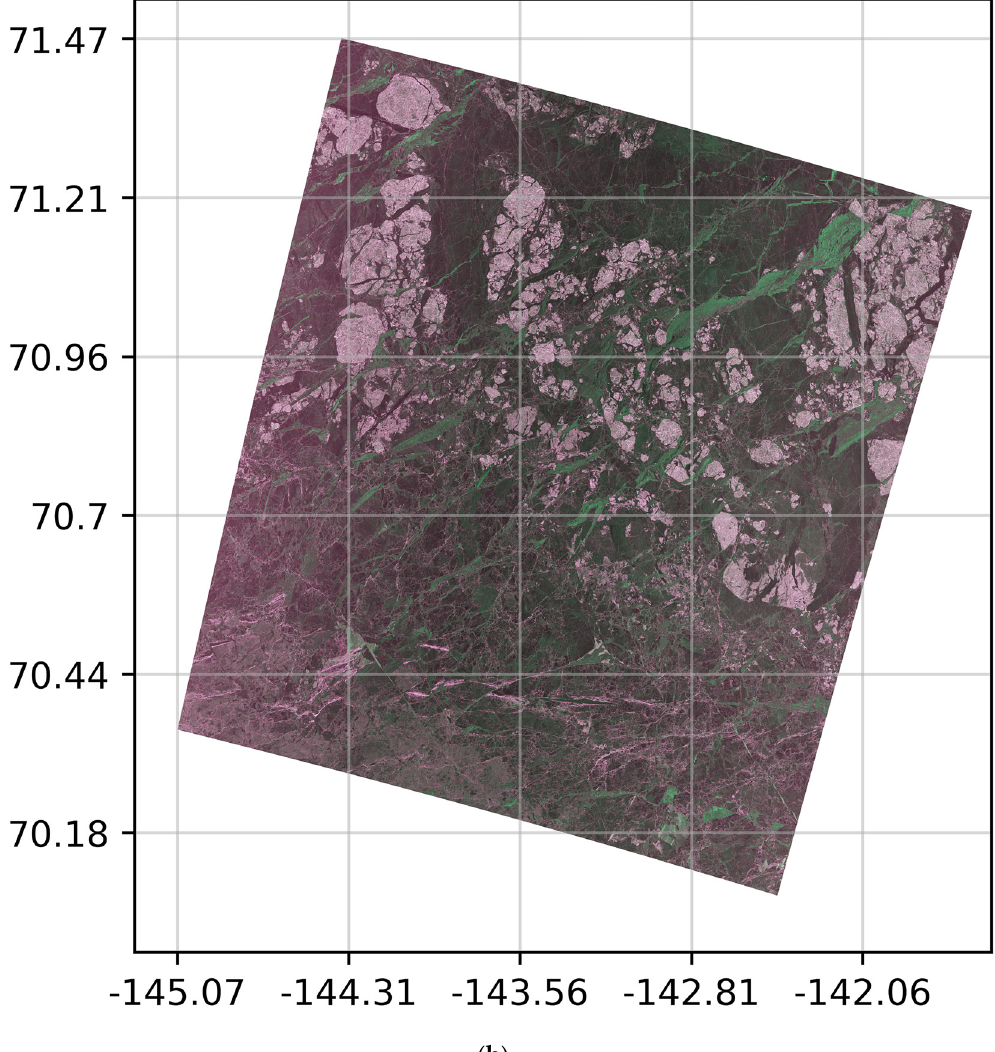
Figure 2. RGB pseudocolor image synthesized from Gaofen-3 SAR data: ( a ) scene 8 in Table 1; ( b ) scene 17 in Table 1.